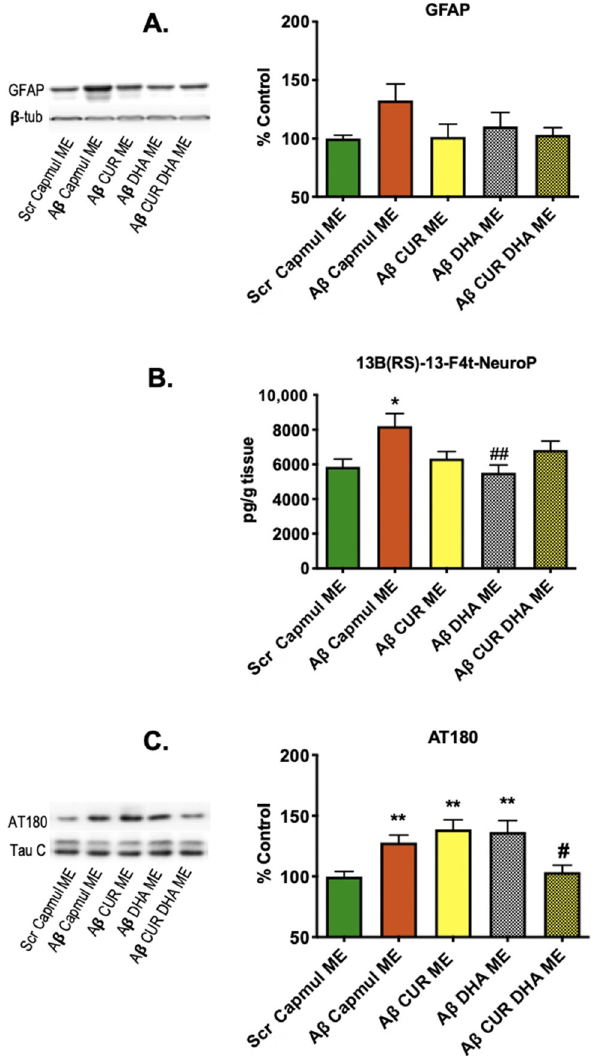
Figure 3. Effect of intranasal administration of CUR-, DHA-, and CURDHA-MEs on GFAP, neuroprostanes, and AT180 levels in oA β 25–35 injected mice. ( A ) Effect of intranasal administration of MEs on inflammation by immunoblot analysis of GFAP on hippocampal lysates. Results are normalized to β -tubulin levels. ( B ) Effect of intranasal administration of MEs on neuroprostane levels (13B(RS)-13-F4t-NeuroP) measured by LC-MS/MS on prefrontal cortices lysates (One-Way ANOVA followed by a Tukey post-hoc test, * p < 0.05 vs. Scr mice, ## p < 0.01 vs. A β Capmul ME mice). ( C ) Effect of intranasal administration of MEs on Tau hyperphosphorylation by immunoblot analysis of the phospho-epitope AT180 on hippocampal lysates (One-Way ANOVA followed by a Tukey post-hoc test, ** p < 0.01 vs. Scr mice, # p < 0.05 vs. A β Capmul ME mice). Results are normalized to Tau-C levels. Scr and A β mice received a ME containing Capmul oil as vehicle. All the results represent the percentage of the control